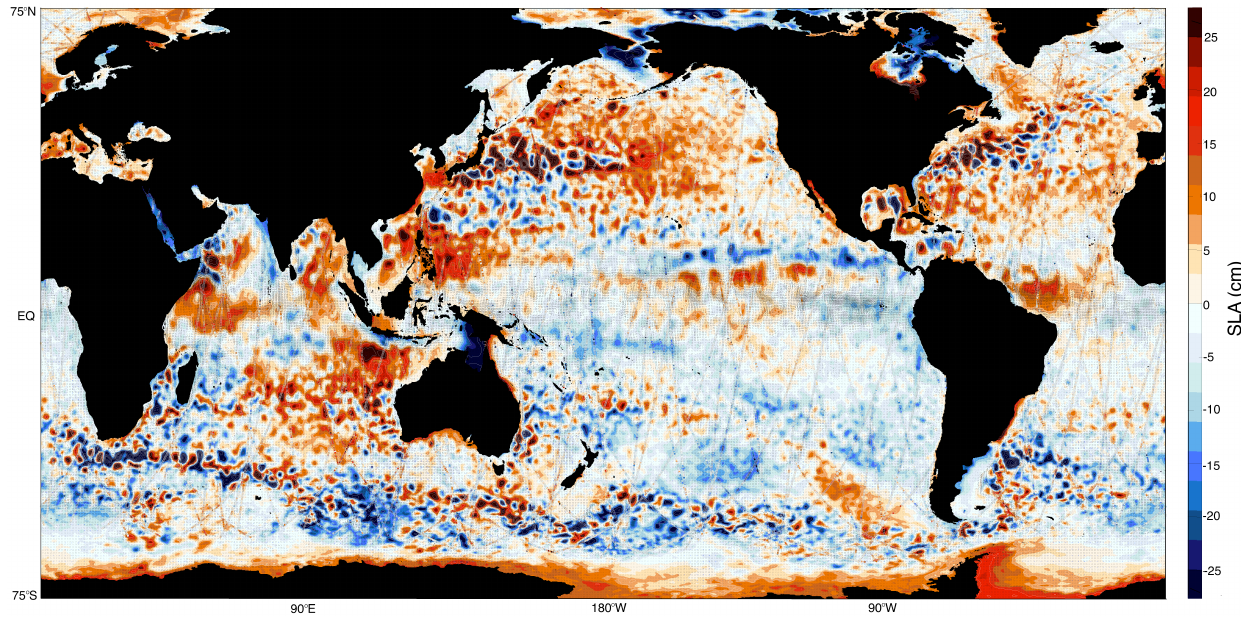
Figure 1. Forecast sea-level anomaly (SLA) from the 1-day cycle system for 9 September 2013. Unassimilated forward independent super- observations are shown with coloured circles and grey outline on the same colour scale. The figure is high resolution and may be zoomed in for a detailed inspection of any region in the electronic version. Also shown are surface current vectors (black arrowheads) and surface wind vectors (blue